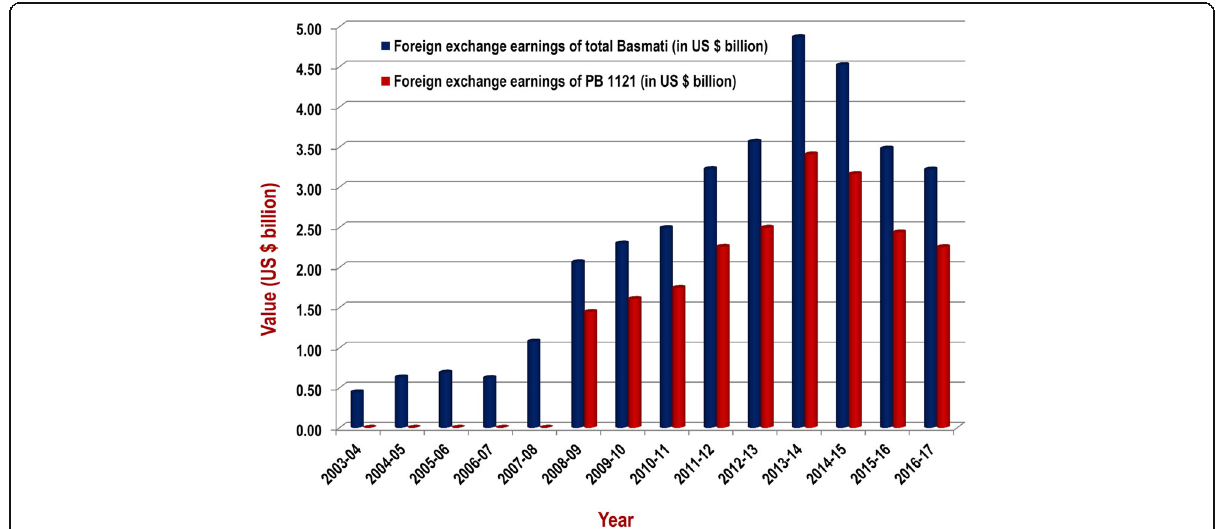
Fig. 7 Trends in foreign exchange earnings through export of Basmati rice since the release of Pusa Basmati 1121 (Source: http://agriexchange.apeda.gov.in/indexp/reportlist.aspx)